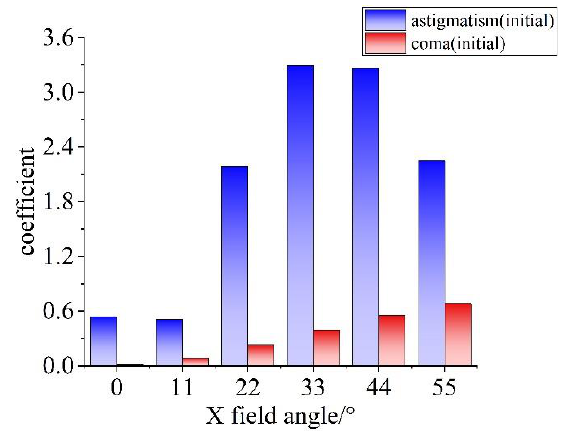
Figure 6. Aberrations of the initial structure.